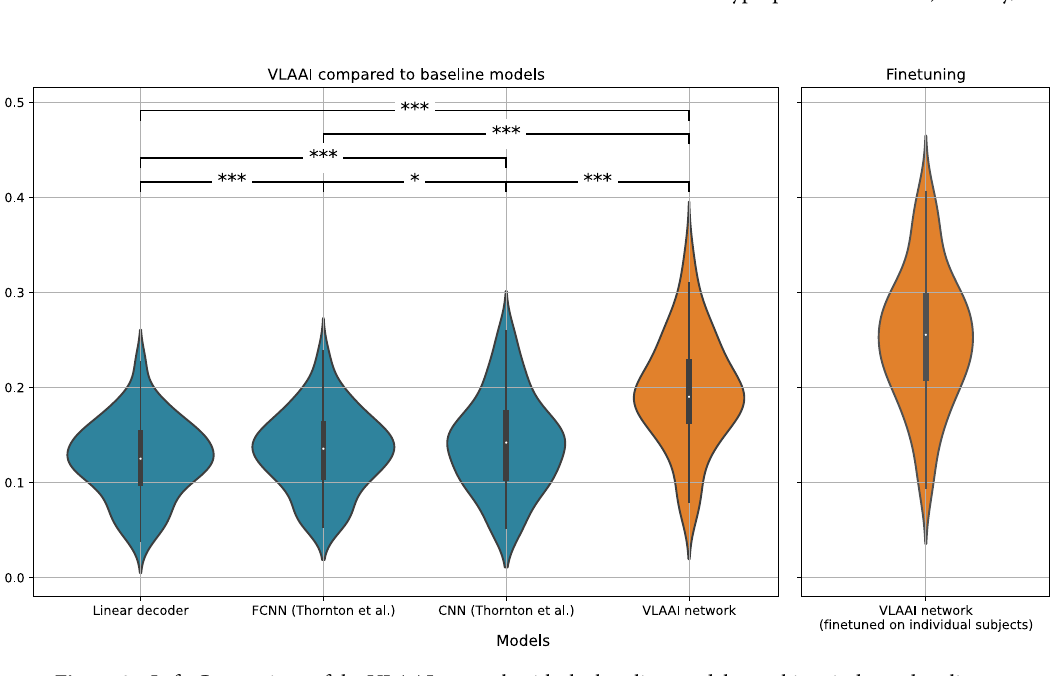
Figure 2. Left: Comparison of the VLAAI network with the baseline models: a subject-independent linear model, and the FCNN and CNN models presented by Thornton et al. 21 . All models were trained on data from all subjects in the single-speaker stories dataset. Each point in the violin plot is the reconstruction score for a subject (80 subjects in total), averaged across stimuli. The FCNN, CNN 21 and VLAAI network significantly outperforms the linear decoder baseline ( p <0.001). The CNN significantly outperforms the FCNN model ( p = 0.02 ) . The VLAAI network significantly outperforms all baseline models ( p < 0.001 ), a relative improvement of 52% compared to the linear decoder. (n.s.: p ≥ 0.05, *: 0.01 ≤ p < 0.05, **: 0.001 ≤ p < 0.01, ***: p < 0.001). Right: A subject-independent VLAAI model is finetuned on data of individual subjects, resulting in one subject-specific VLAAI model per subject. The same finetuning procedure as in the Finetuning subsection is followed. The training set of the single-speaker stories dataset was used to train and finetune the subject- independent model. The test set remains unseen during training/finetuning. Each point in the violin plot is the reconstruction score for a subject (80 subjects in total), averaged across